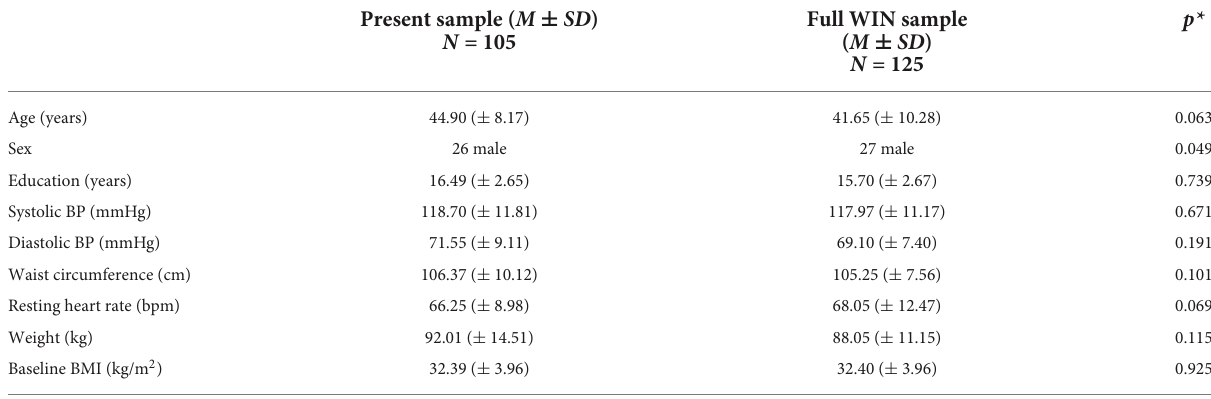
TABLE 2 Baseline demographic comparison of full WIN sample to present subsample with available genetic and pCASL